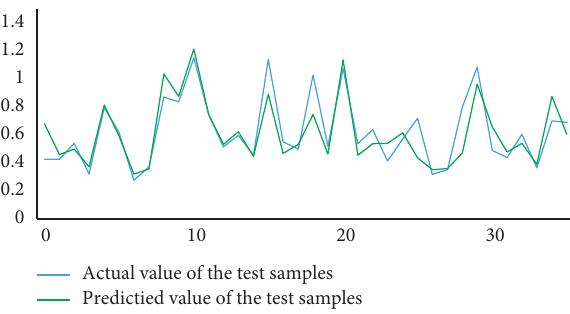
Figure 6: The test